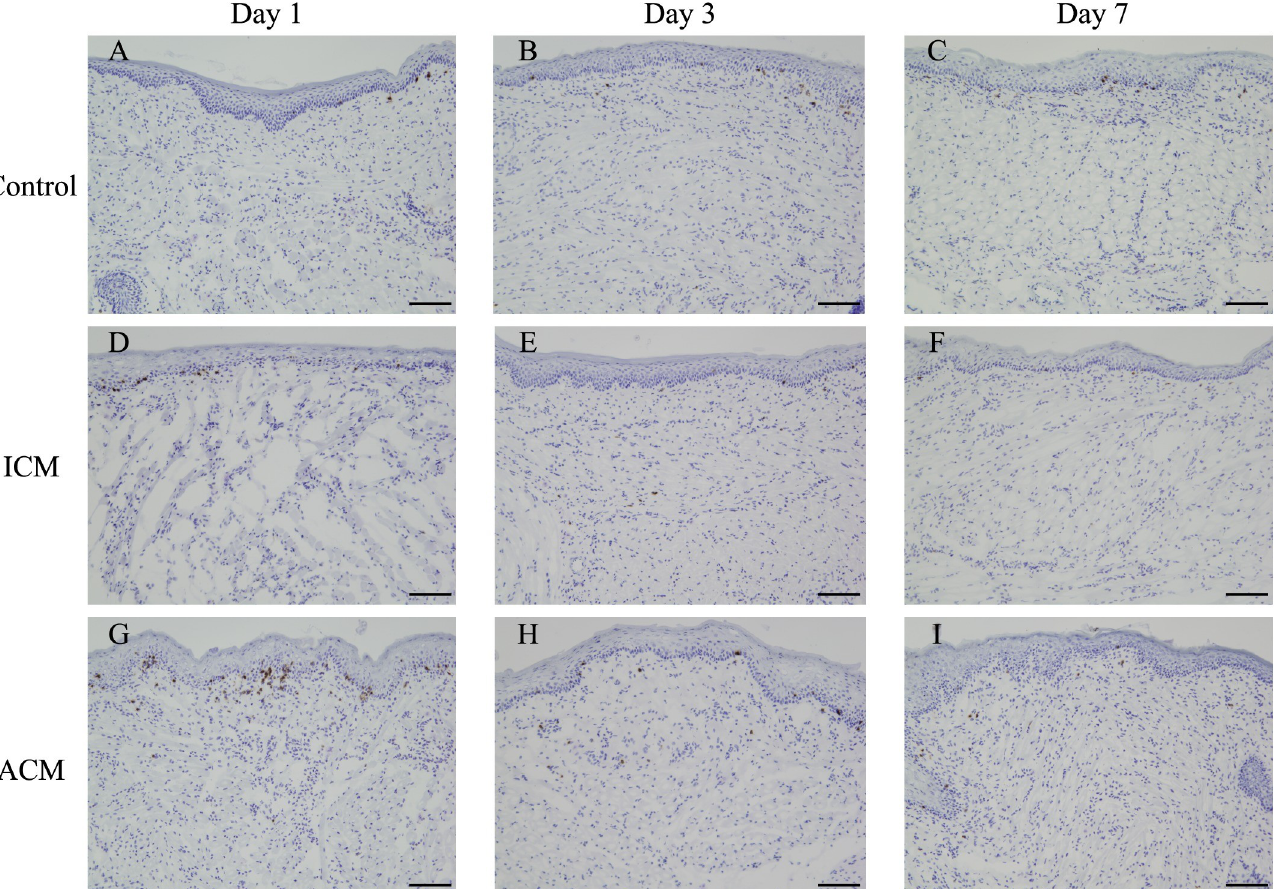
Fig 5. Immunohistochemical analyses of accumulating T cells in the oral mucosa of Ni-induced allergic mice. Frozen buccal mucosa sections were stained with anti-CD3 antibodies at days 1, 3, and 7 after challenge. At day 1 after challenge, infiltrating CD3-positive T cells were present in the epithelial basal layer and the upper dermis in ACM mice (G). Scale bar = 10 μ